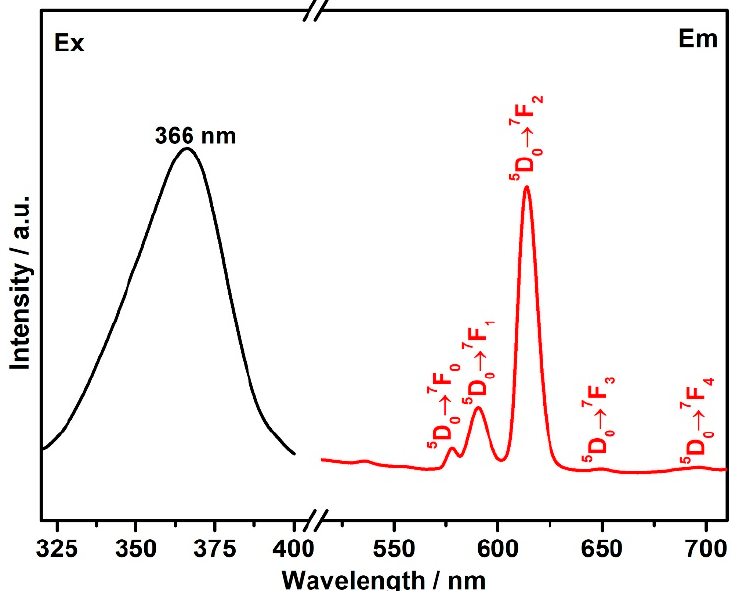
Figure 6. Excitation and emission spectra of hybrid material Eu(tta) 3 bpdc-SiO 2 @mTiO 2 in solid state at room temperature.